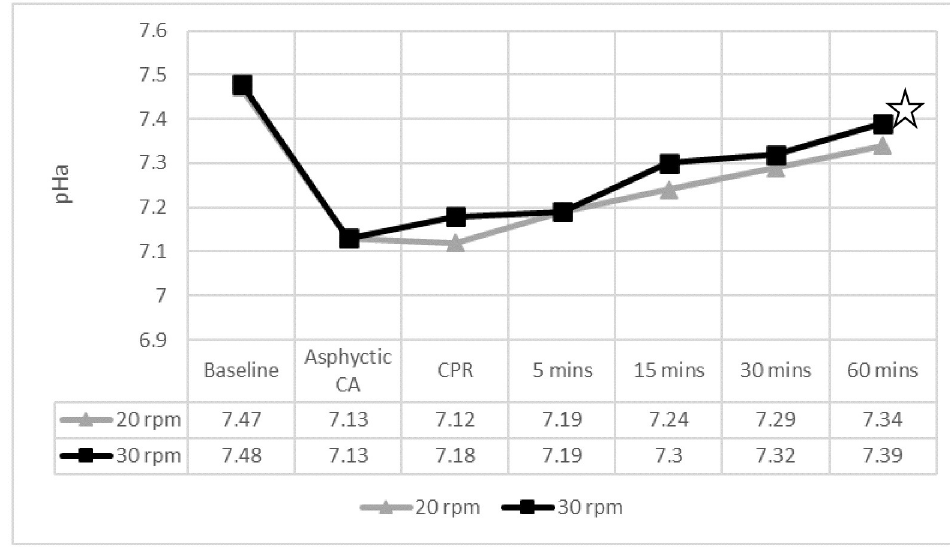
Fig 3. Arterial pH levels throughout the experiment. ✩ p < 0.05. pHa: arterial pH; CA: cardiac arrest; CPR: cardiopulmonary resuscitation; mins: minutes. 5 mins to 60 mins: time after ROSC.